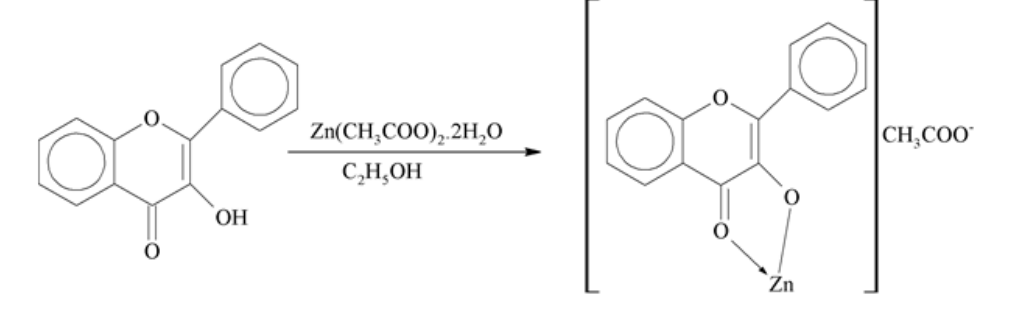
Scheme 13: Synthesis of zinc-flavonol complex.